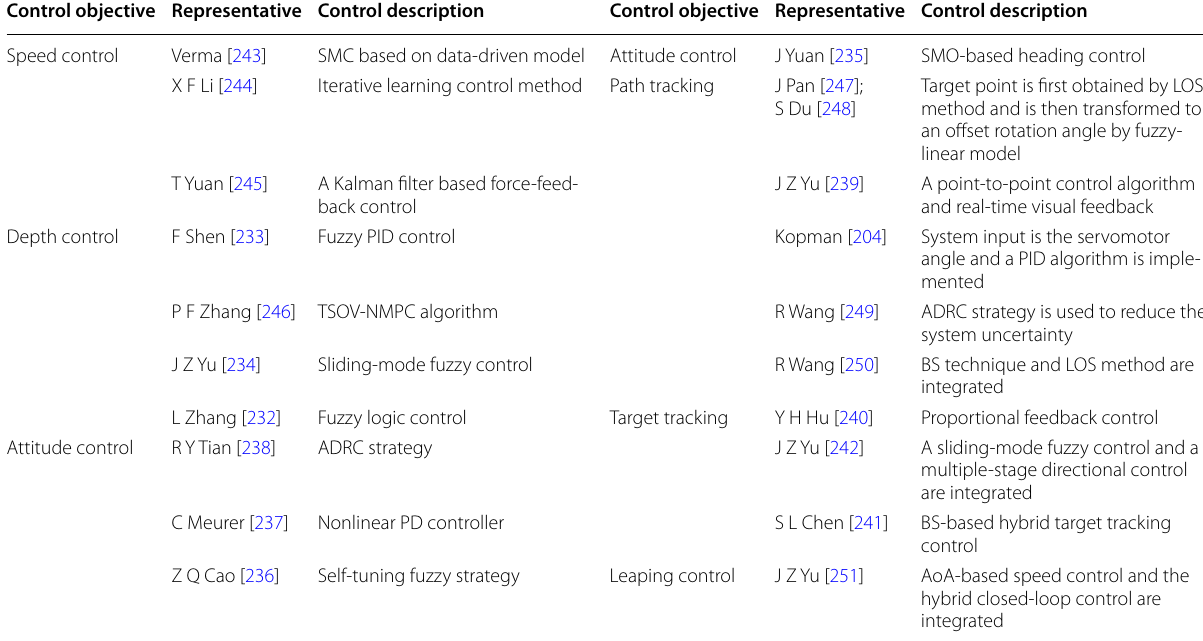
Table 6 Overview of close-loop motion